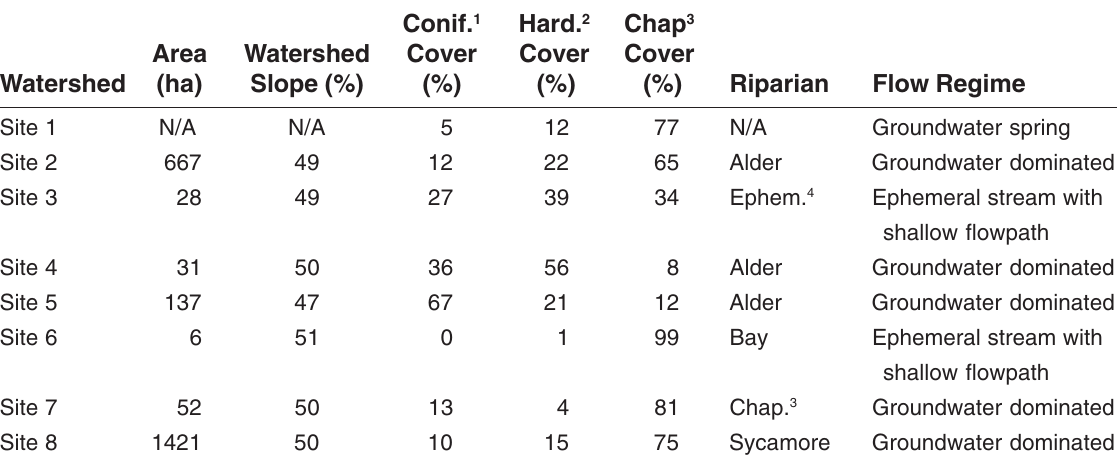
Watershed Characteristics Conif.